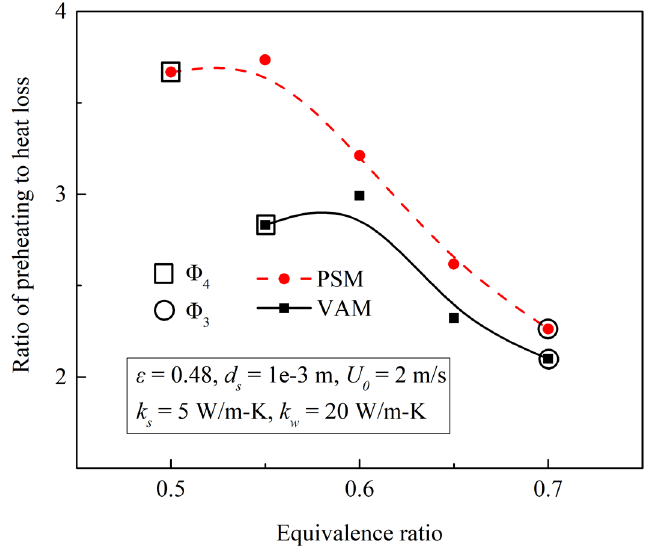
Figure 10. Variation of R p-hl obtained by the PSM and VAM.